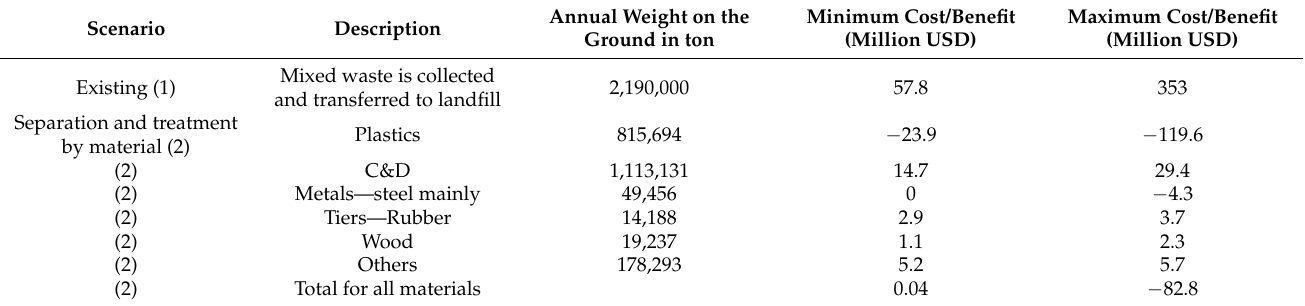
Table 6. Economic analysis based on two different waste treatment